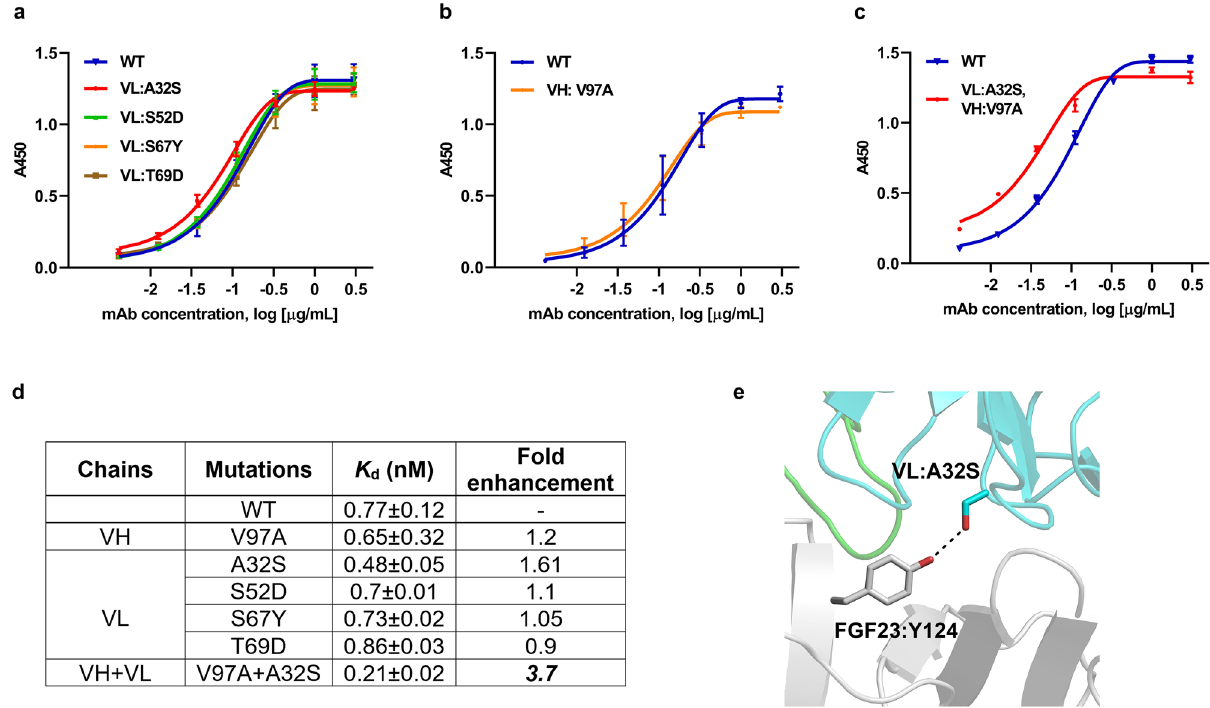
Figure 5. Binding activity of Burosumab variants designed to enhance affinity based on pose27. Four mutations on the light chain were created and tested for binding to wild-type FGF23 using ELISA ( a ). Only A32S mutations showed 1.6-fold affinity enhancement based on K d value compared with wild-type Burosumab. V97A, which showed small affinity enhancement (1.2-fold) from alanine scanning promoted the binding affinity up to 3.7-fold when combined with A32S ( b , c , d ). VL:A32S is predicted to form a new favorable hydrogen bond formation with Y124 of FGF23 ( e ). Curves were drawn by GraphPad Prism version 8.4.3. A450 refers to absorbance at 450 nm. Structure was created by PyMOL version